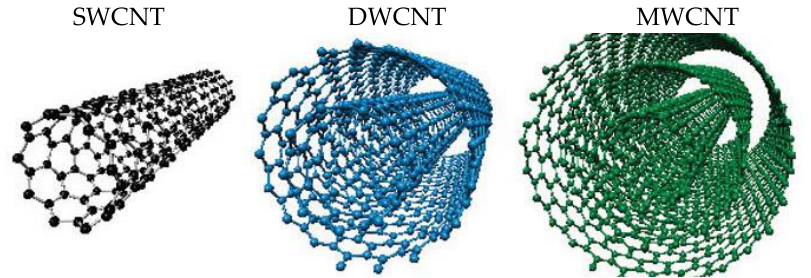
Figure 2. Structure of carbon nanotubes, CNTs.